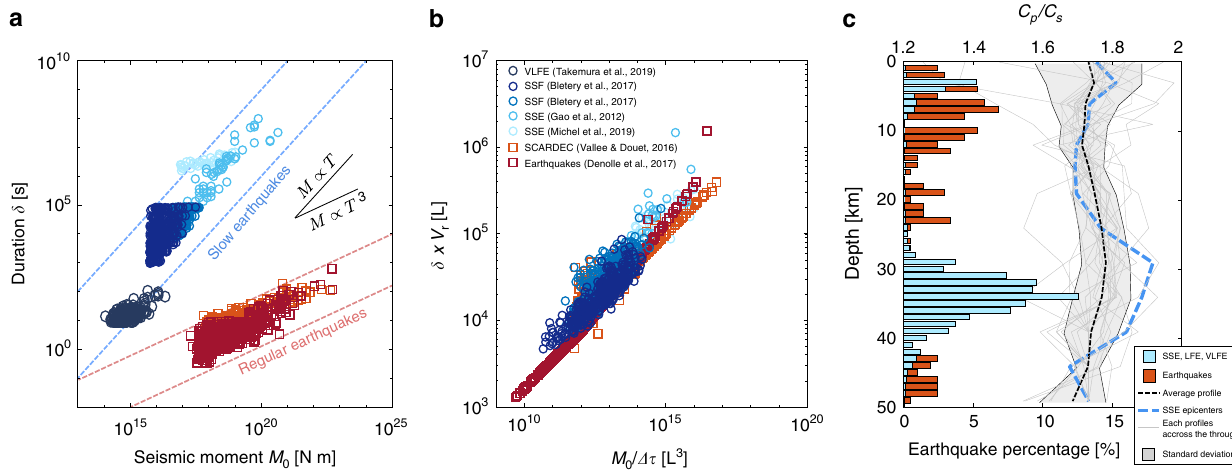
Fig. 1 Scaling relation between the different modes of slip. a Scaling law for natural earthquakes observed from seismological or geodetical measurements. Blue circles correspond to slow slip events (so-called SSEs), deep low-frequency earthquakes (LFEs), very-low-frequency earthquakes (VLFEs) and slow slip fronts (SSF) 7,9,10,13, − 15,19,62 . Regular earthquakes are presented by the red circles. The source time functions used were downloaded from the SCARDEC database 16,63 . Most of the data for regular earthquakes were taken from recent studies 62,63 . The dashed lines correspond to the regular trend deduced from natural observations for both slow (blue dashed lines) and fast earthquakes (red dashed lines) 1,7 . b Normalised scaling low assuming the average rupture velocity and the average static stress drop as determined in previous work for both regular 62,63 and slow slip events 1,7,9,10,15,19 . c Hypocentral distribution of both slow and fast earthquakes in Japan 7,8,13 – 19 . Lines present the wave velocity pro fi les obtained from the analyses of seismic and teleseismic waves in the subducting Philippine Sea plate in the Tokai district, Japan 20,23 . The blue dashed line corresponds to the pro fi le cross-cutting LFE hypocenters 23 . The black dashed line corresponds to the average of all grey pro fi les obtained along the subduction trench 23 . The grey area corresponds to the standard